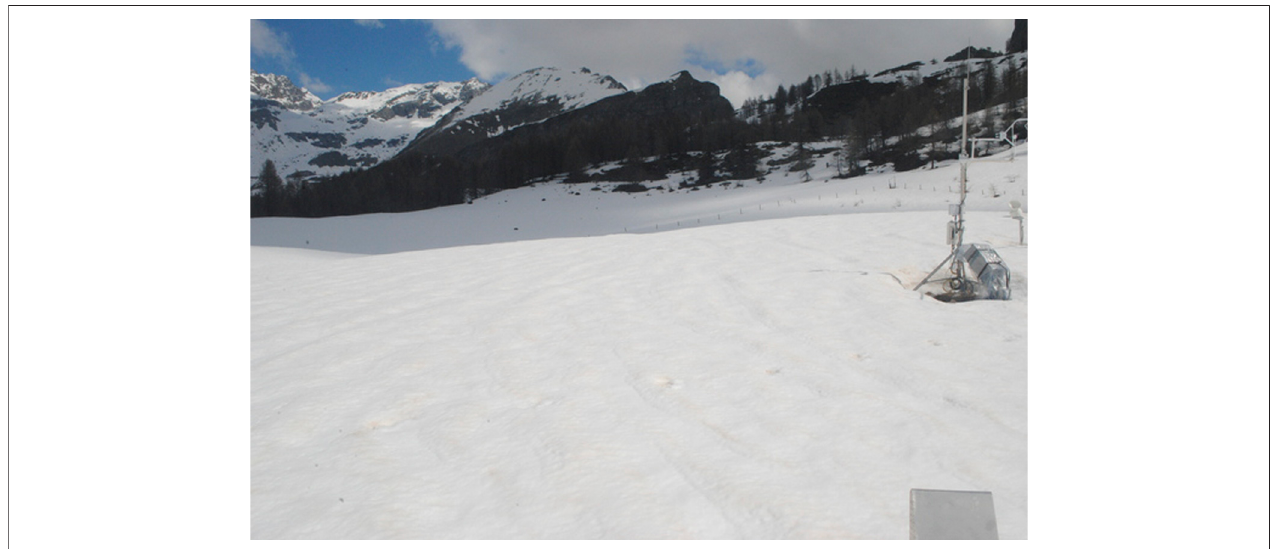
FIGURE 1 | The photo of the Torgnon site in Italian Alps (45.845012N, 7.578517E) taken on May 17, 2018. Dust is visible on the surface of snow.